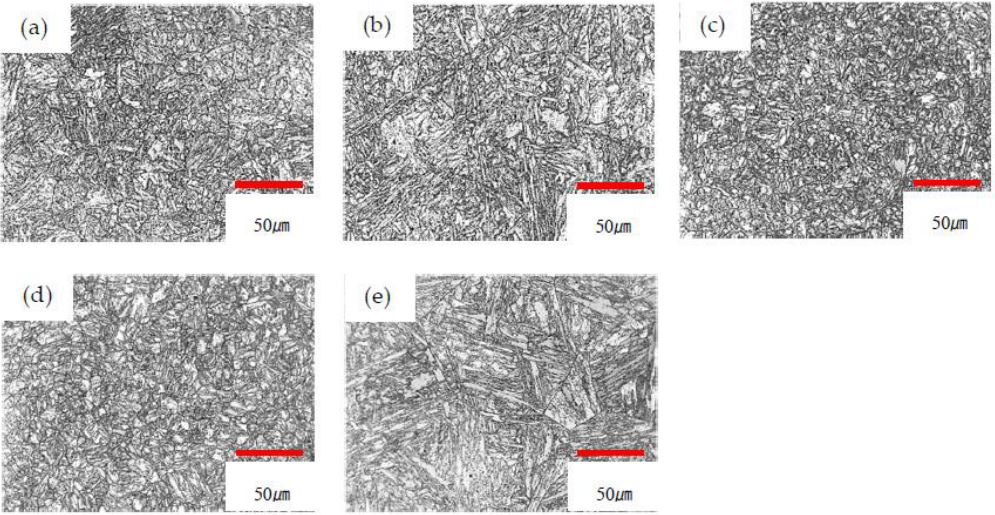
Figure 5. OM images of the Gr.92 steel specimens subjected to different intermediate heat treatment conditions: ( a ) as-received; ( b ) 800 ◦ C, 6 min; ( c ) 1050 ◦ C, 6 min, and 800 ◦ C, 6 min; ( d ) 1050 ◦ C, 30 min, and 800 ◦ C, 6 min; ( e ) 1150 ◦ C, 6 min, and 800 ◦ C, 6 min.